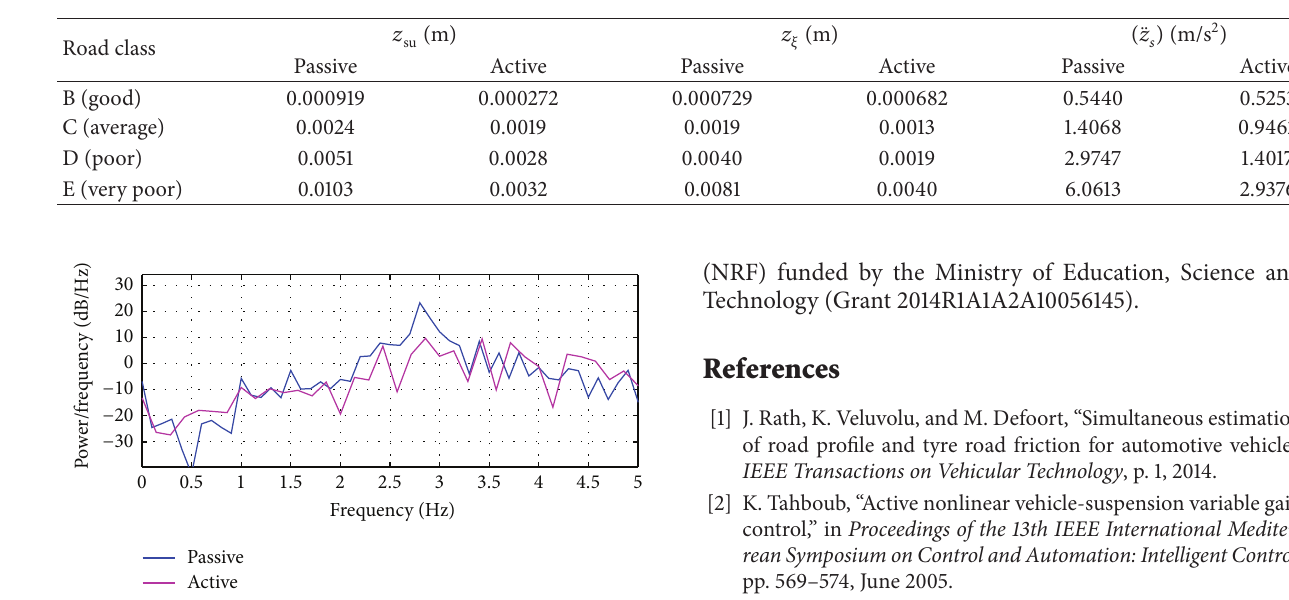
Table 1: RMS values of suspension deflection, tire deflection, and vertical acceleration.